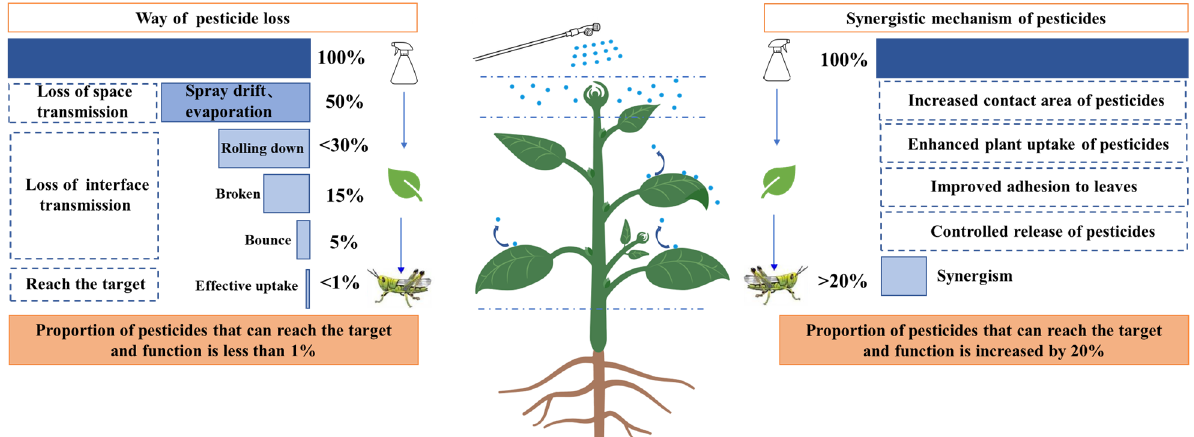
Figure 1. Schematic diagram of pathways of pesticide loss and synergistic approaches to improving pesticide utilization. The left figure represents the path of pesticide loss, and the right figure represents the synergistic mechanism of pesticides. The percentages in the figure (e.g., 100%, 50%, etc.) represent the utilization rate of pesticides.